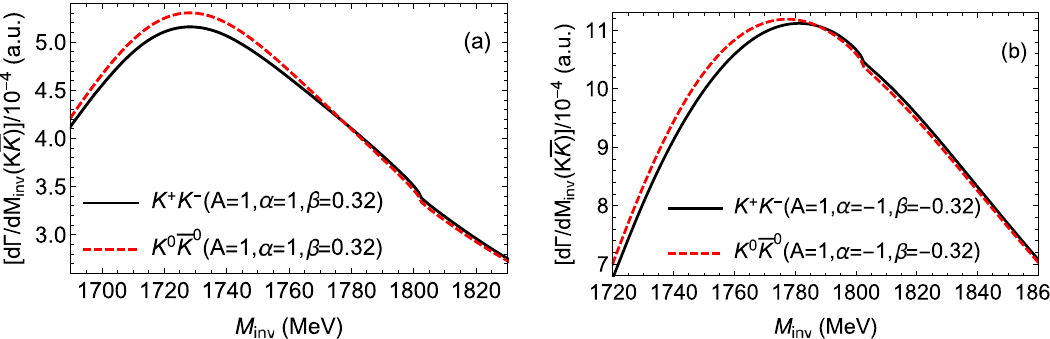
Fig. 7 Differential decays for the reaction J /ψ → φ K + K − , taking distinct parametrizations for the parameter A . The curves representing the background encoded only in the parameter A (i.e. α,β = 0) have been also shown